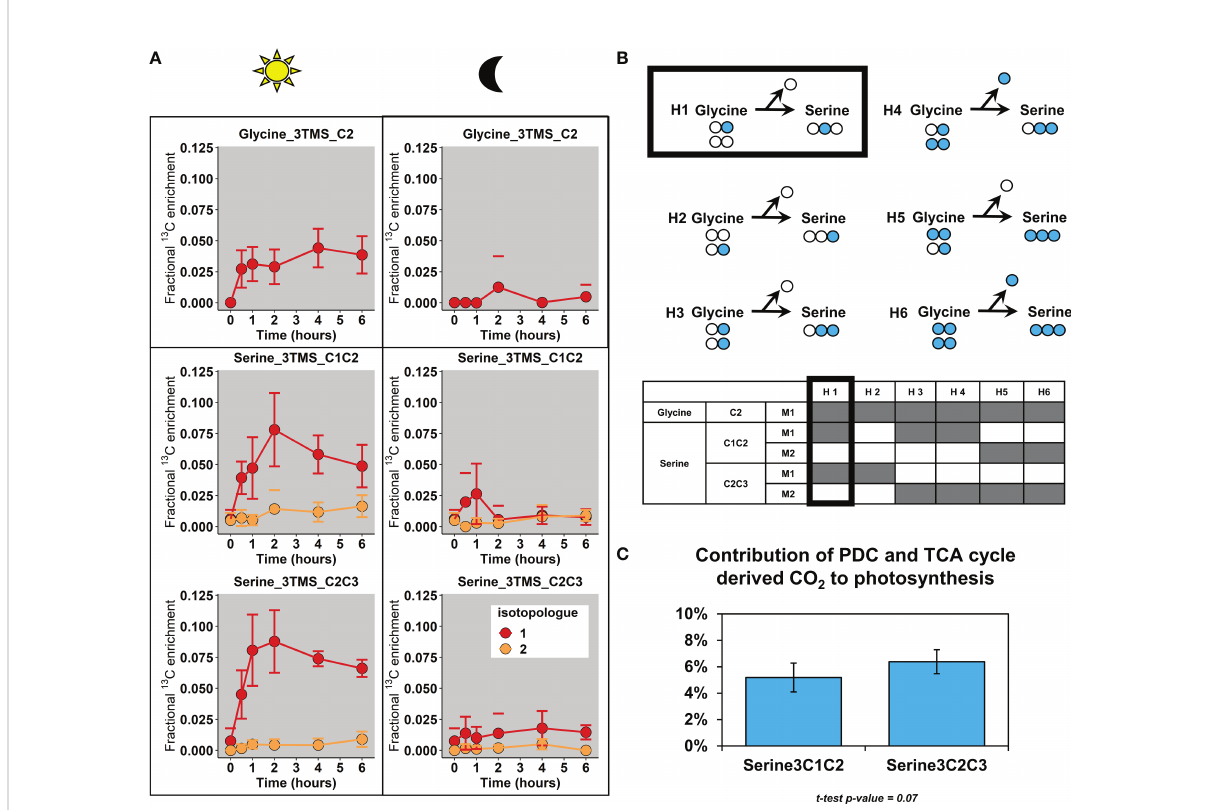
FIGURE 7 Fractional contribution of PDC and TCA-cycle derived decarboxylations to photosynthesis. (A) , Fractional 13 C enrichment at the isotopologue level for glycine and serine. (B) , Working hypotheses to explain the photorespiratory-dependent labeling pattern of glycine and serine. (C) , Estimation of the fractional contribution of PDC (pyruvate dehydrogenase complex) and TCA-cycle CO 2 to photosynthesis with Serine (expressed in %). For these calculations, only the timepoint T4 and T6 hours were used and pooled (metabolic and isotopic steady-state, assumption with 13 C/ 12 C of CO 2 released). The results are presented as the mean ± SD of four independent biological replicates. Statistical comparison of the two serine fragments was performed with a